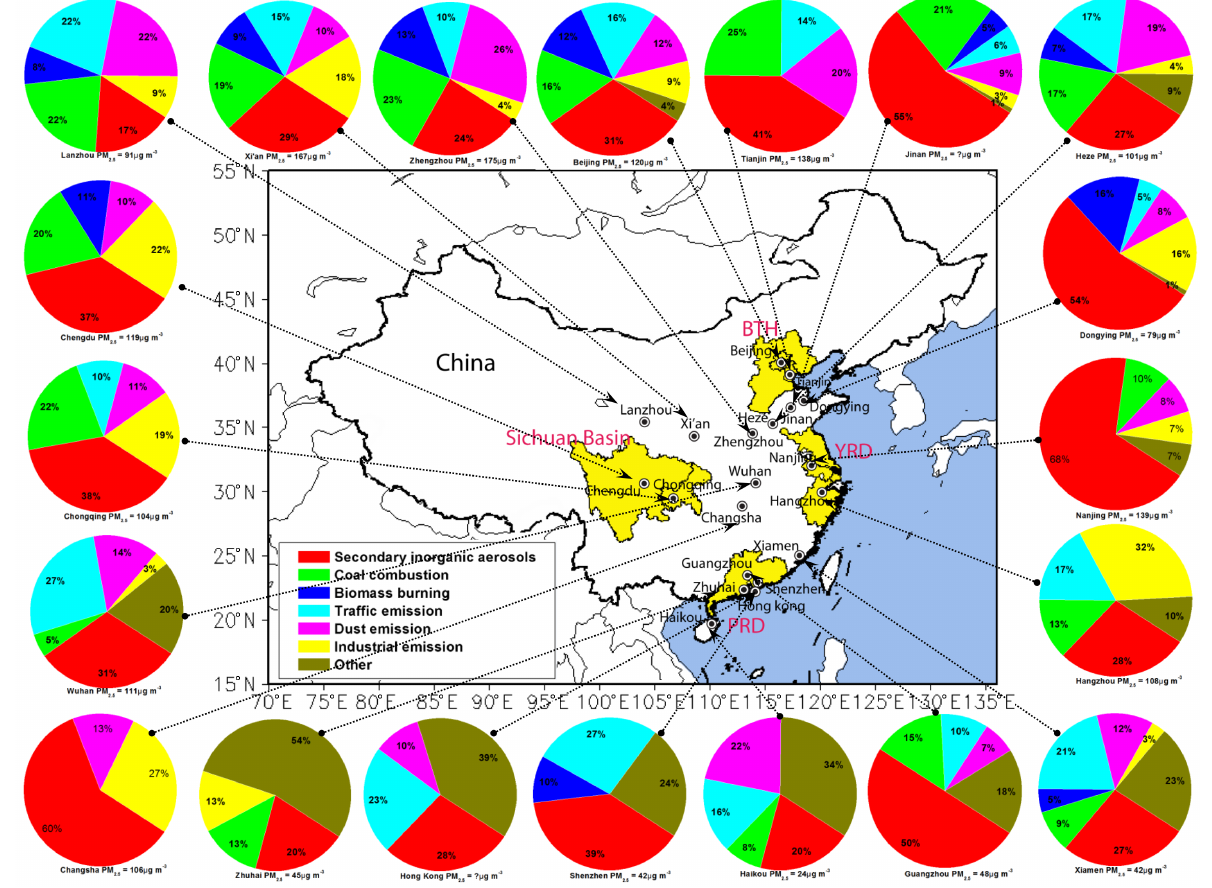
Figure 10. Annual contributions of PM 2 . 5 dominant sources across